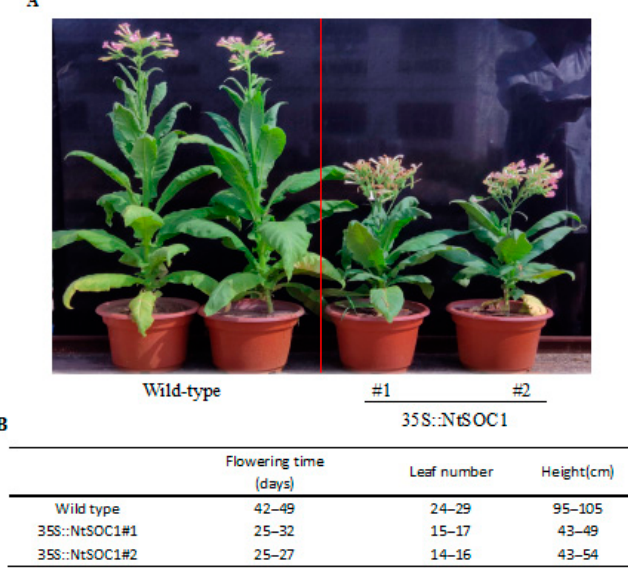
Figure 7. Phenotypes of NtSOC1 / NtMADS133 overexpressed transgenic lines in tobacco. ( A ) Growth of wild-type and two NtSOC1 overexpressed lines. Seedlings were grown in soil for 100 days. Representative plants were photographed. ( B ) Quantitative analysis of wild-type and two NtSOC1 overexpressed lines on the height and flower time. Three independent biological experiments with 12 individual plants per transgenic lines were calculated.